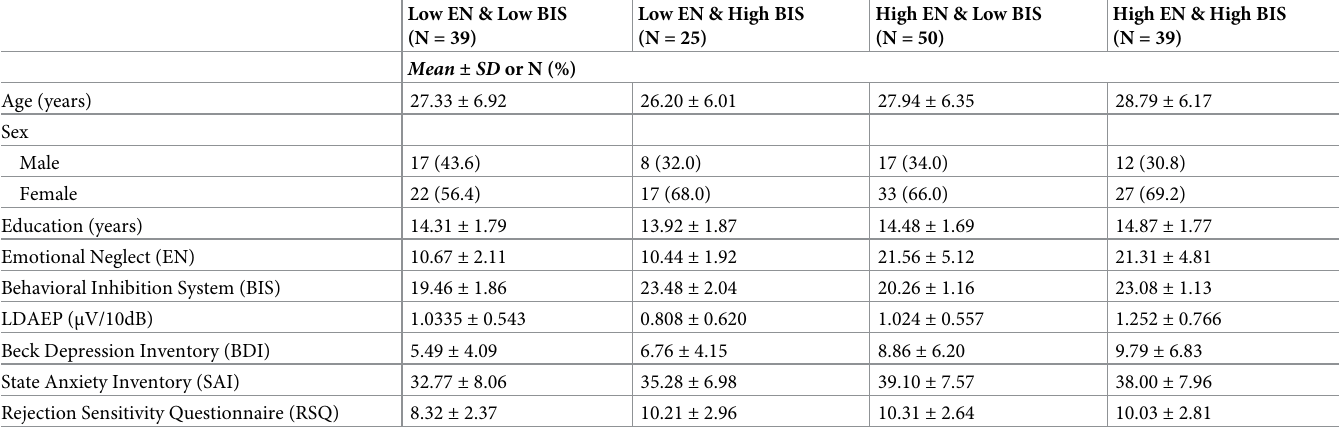
Table 1. Comparison of demographic, psychological, and behavioral characteristics in participants with low EN and low BIS scores, low EN and high BIS scores, high EN and low BIS scores, and high EN and high BIS scores. Low EN & Low BIS (N =